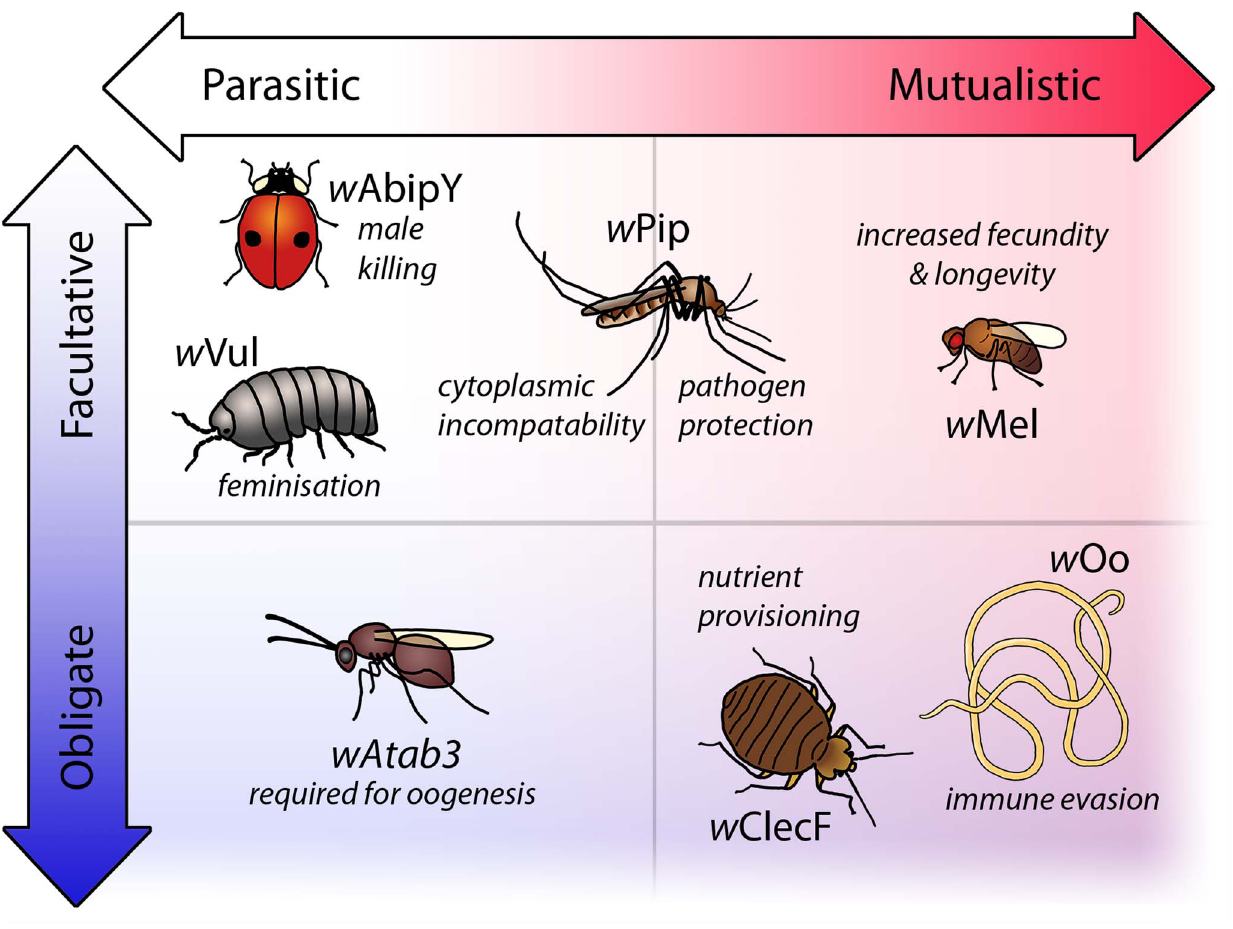
Figure 1. Selected examples of phenotypes resulting from natural Wolbachia symbioses. Wolbachia produces a large spectrum of phenotypes in their hosts ranging from parasitic to mutualistic traits existing as either facultative relationships or associations that have evolved to become obligate. Reproductive parasitism by Wolbachia is well recognised. For example, in the ladybird Adalia bipunctata , infection results in death of infected males during development to the benefit of female siblings (male killing) [72]; in the woodlouse Armadillidium vulgare , infection causes development of infected genetic males into females (feminisation) [73]; and in the mosquito Culex pipiens , Wolbachia strain w Pip produces cytoplasmic incompatibility (CI), in which crosses between infected males and uninfected females result in embryonic death. Wolbachia symbioses may also provide benefits to the host, such as increases in fecundity and longevity in Drosophila melanogaster [74]. In some species, mutualistic traits coexist with reproductive phenotypes, such as in Culex pipiens , where the CI-inducing strain w Pip also provides protection from mortality associated with Plasmodium relictum [13]. In some host species, all individuals are infected and this association is often mutualistic, as in the bedbug Cimex lectularius in which Wolbachia supplies essential B vitamins [10], or in the filarial parasite Onchocerca ochengi , where the presence of the bacteria is associated with the vertebrate host mounting an ineffective immune response [75]. However, in the parasitic wasp Asobara tabida , strain wAtab3 is essential for oogenesis, making the relationship obligatory without any known benefits to the host